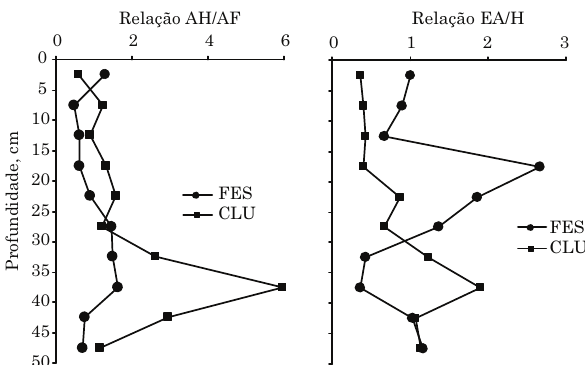
Figura 2. Relações AH/AF e EA/H em profundidade no Campo Limpo Úmido (CLU) e na Floresta Estacional Semidecidual